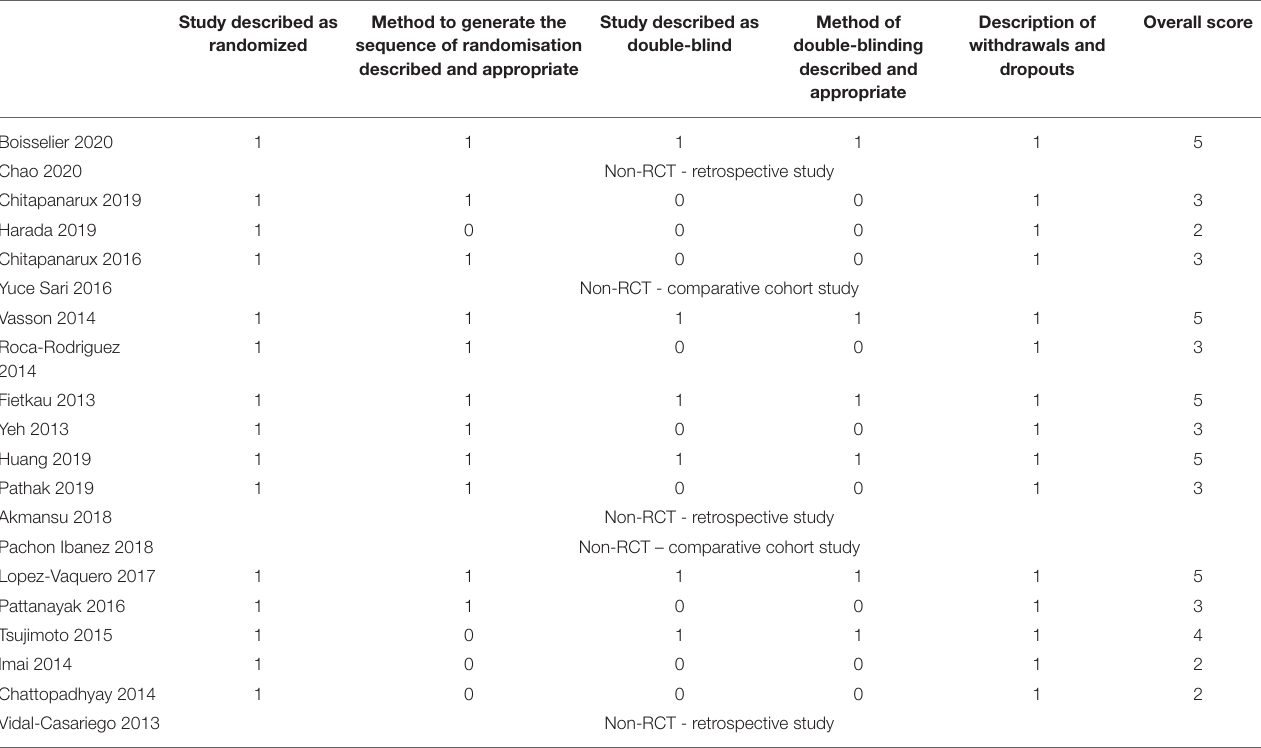
TABLE 3 | Summary of methodological quality assessment using the Jadad